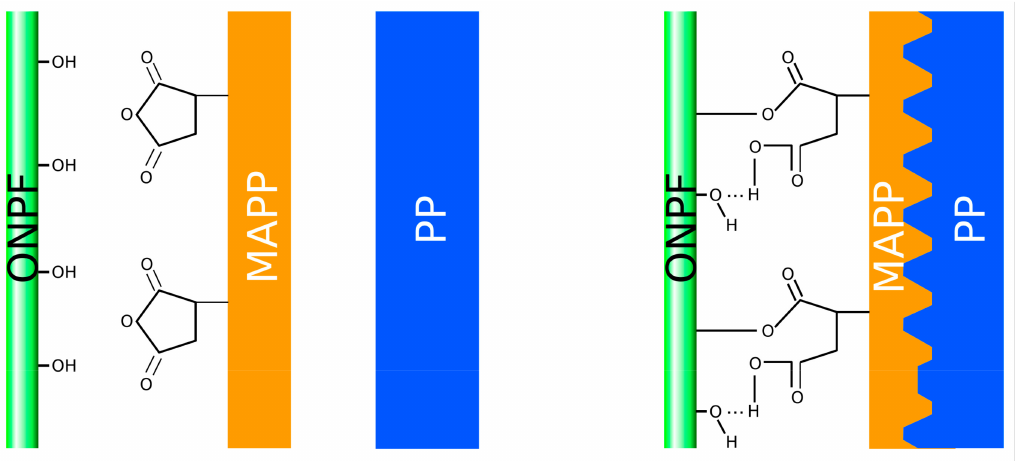
Figure 3. Schematic interactions between ONPF, PP and MAPP in the composite